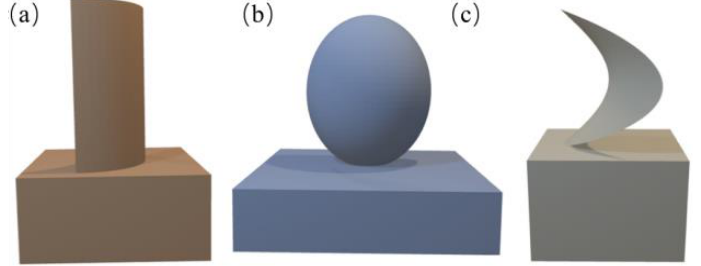
Figure 2. Standard surface model of CSSP: ( a ) cylinder; ( b ) ellipsoid; ( c )